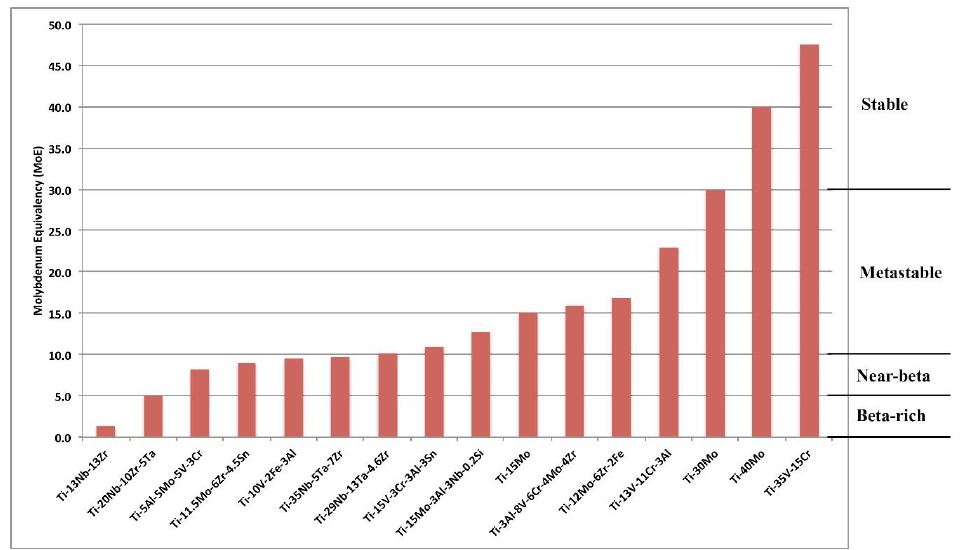
Figure 4. A plot of molybdenum equivalency (MoE) of model binary and commercially important beta Ti alloys listed in Table 2. Alloys with 0 ≤ MoE < 5 are beta-rich, alloys with 5 ≤ MoE < 10 are near-beta, alloys with 10 ≤ MoE < 30 are metastable, and alloys with MoE > 30 are denoted stable.